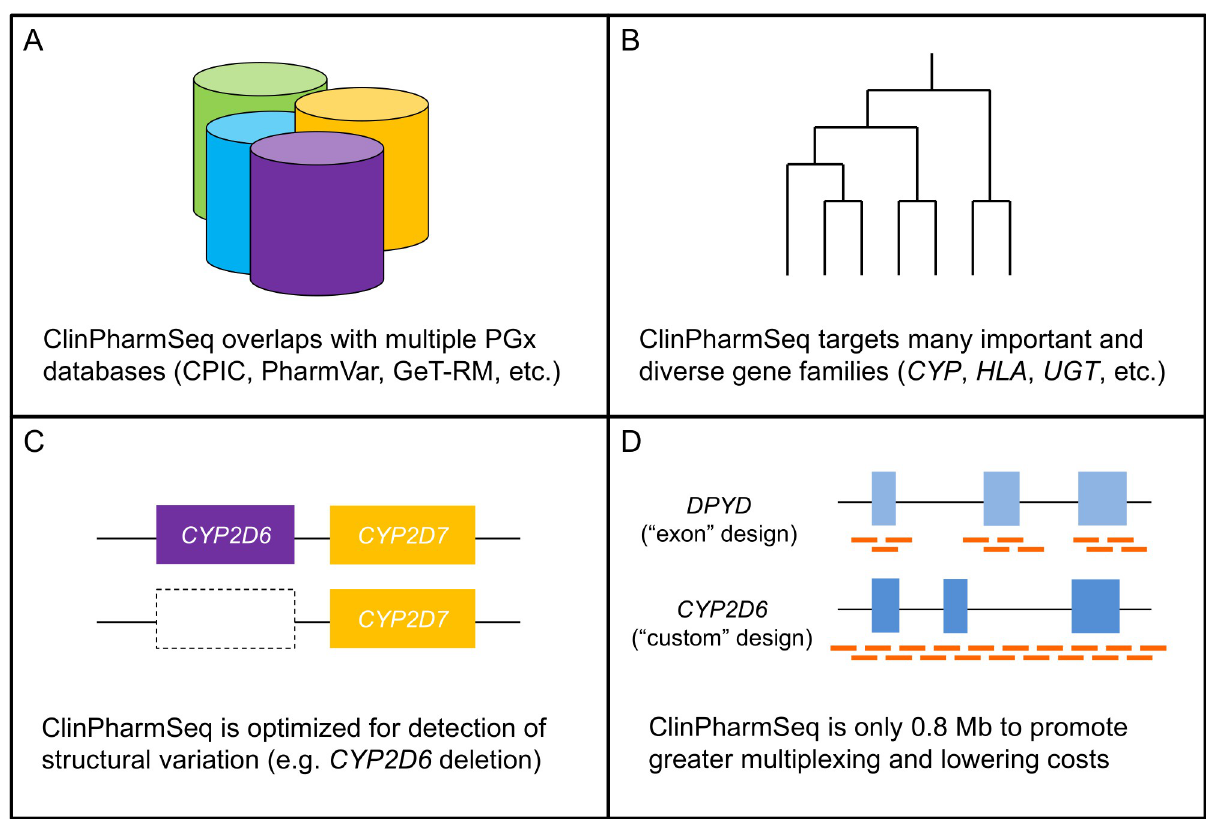
Fig 1. Major design strategies used to construct